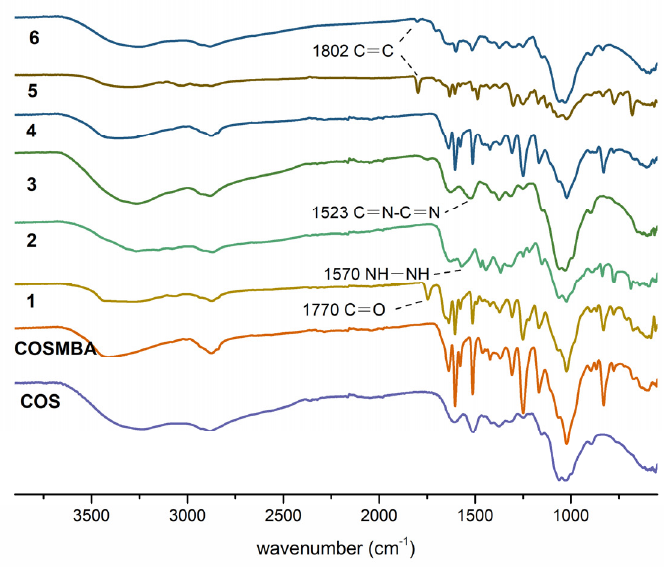
Figure 1. FTIR spectra of fluoroalkenyl COS derivative.